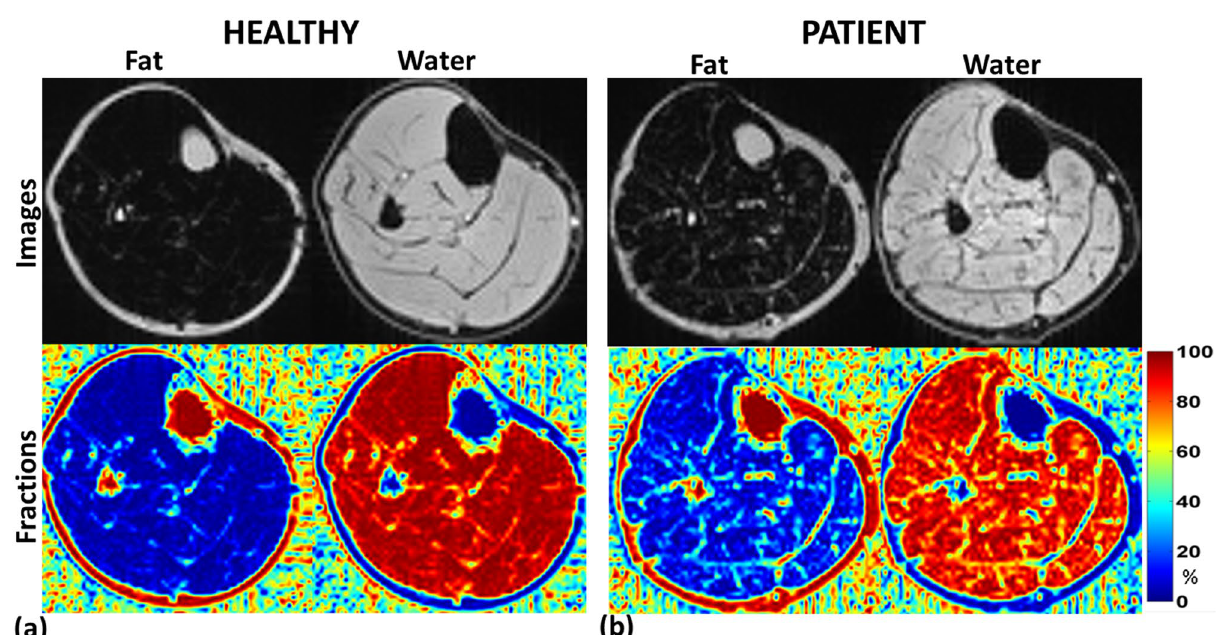
Figure 6. Water-fat Imaging using multi-point Dixon technique. ( a ) shows water-fat imaging results after processing in a healthy volunteer. The first column shows fat image, and the fat fraction in the muscle, and the second column shows the water image and corresponding water fraction. ( b ) shows water-fat imaging results after processing in an HF patient, with the first column showing fat image and fat fractions, while the second column shows the proton image and water fraction. HF patients show considerably increased fatty infiltration in the